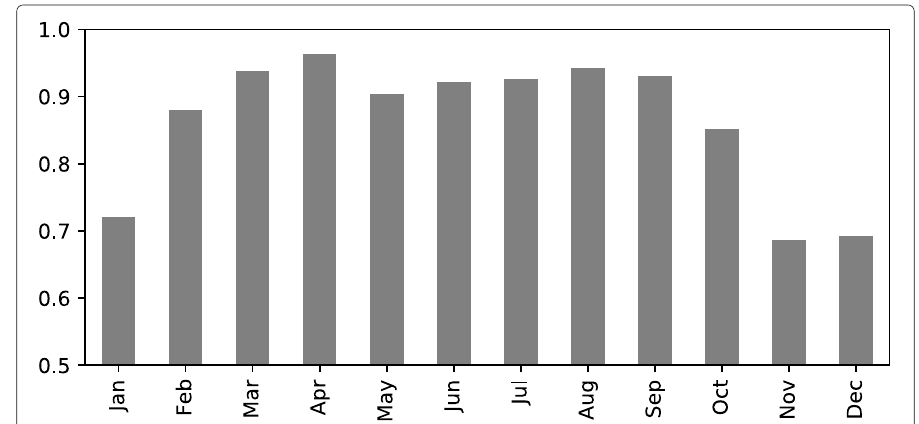
Fig. 3 Monthly Pearson correlation between ERA5 GHI at the system’s location and measured power